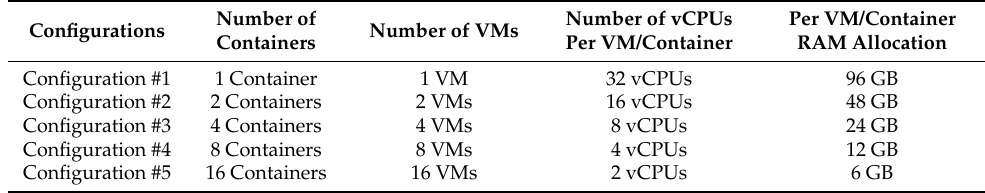
Table 3. Five different configurations of VMs/containers for